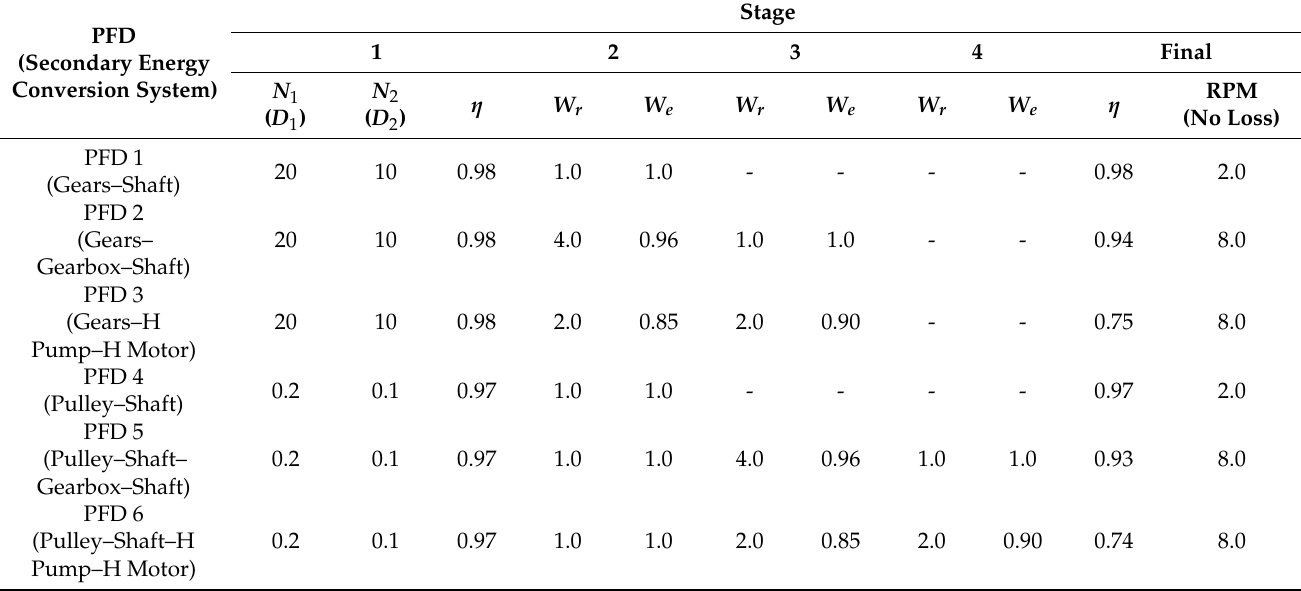
Table 5. Parameter for each stage according to the